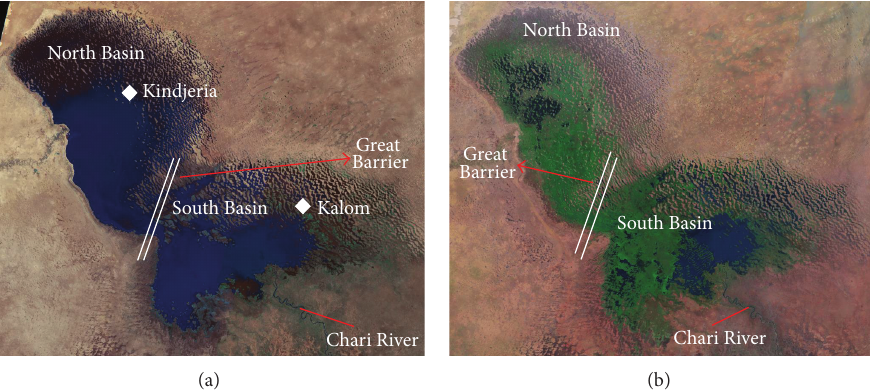
Figure 2: Landsat 5 images of Lake Chad: (a) January 1973 and (b) May 2003 (modified from Landsat 5 images; courtesy of NASA).